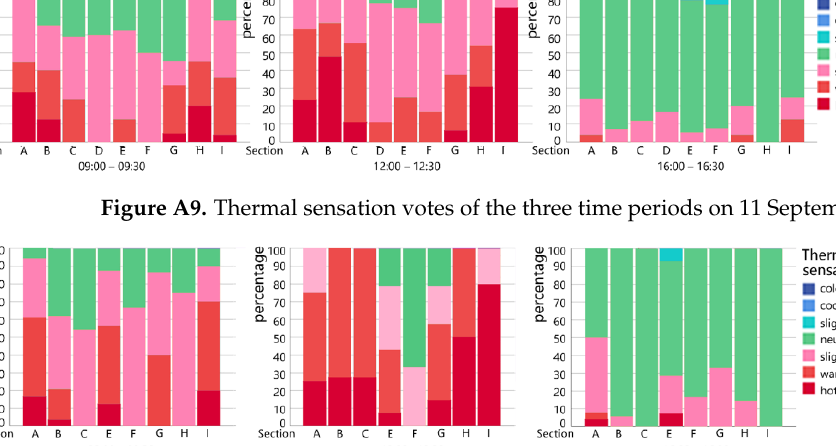
Figure A8. Solar radiation sensation votes of the three time periods on 12 September.